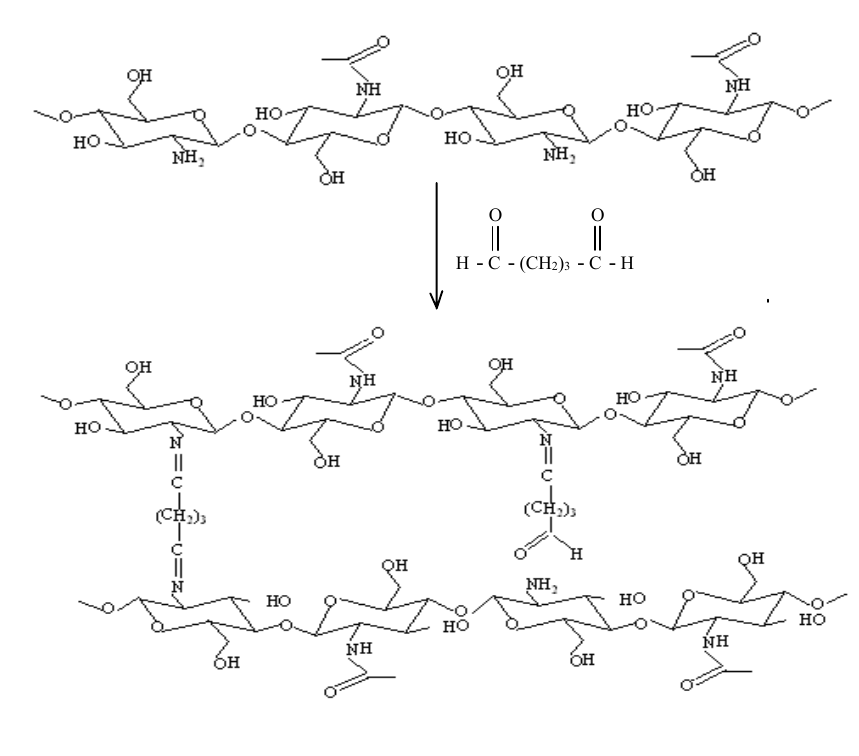
Fig. 5.B Process of crosslinking